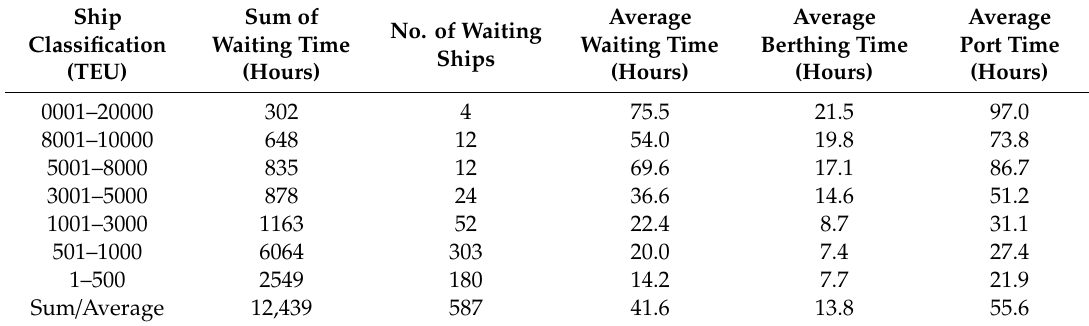
Table 10. Average Waiting Time, Berthing Time, and Port Time Based on Ship Size Classification.